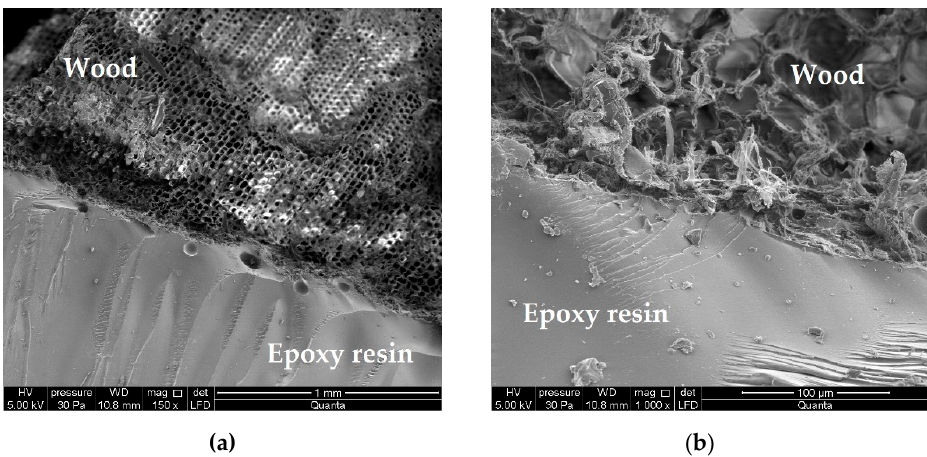
Figure 1. Microstructure of the connection of the LG 385 + HG 385 epoxy resin and Pinus Sylvestris L. wood in the beam reinforced with basalt rods, subjected to fuve-year atmospheric impact and biological degradation: a ) 150× zoom, b ) 1000× zoom.